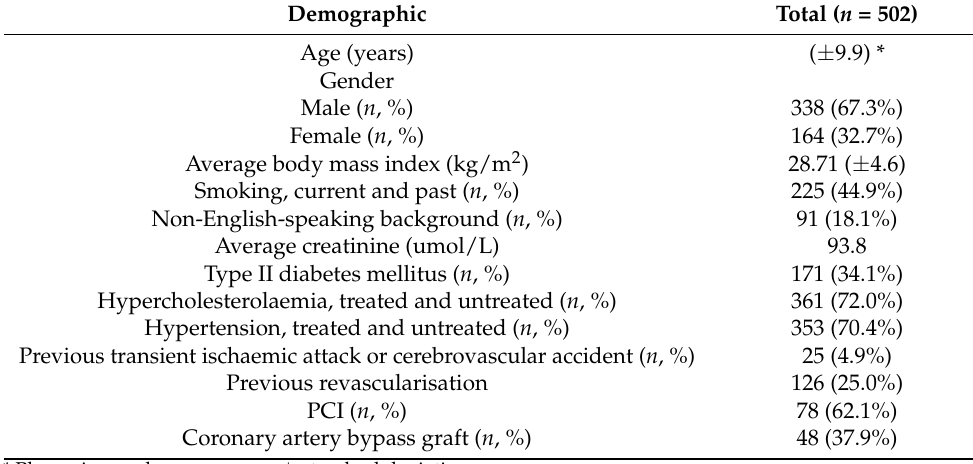
Table 1. Baseline